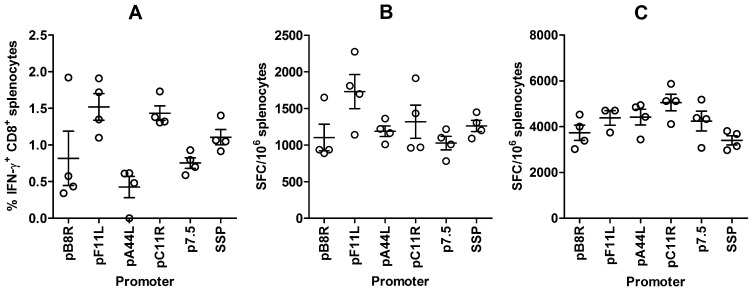
Cellular immunogenicity of recombinant MVA antigen (tPA-Pb9-rLuc8PV) driven by endogenous promoters compared to p7.5 and SSP in single-shot (A, B) or heterologous prime-boost (C) vaccination regimens.For single-shot (A, B), BALB/c mice were immunized i.m. with 106 pfu rMVA) and splenic CD8+ T cell responses to Pb9 peptide were determined 7 days later by intracellular cytokine staining and flow cytometry (A) or IFN-γ ELIspot (B). For prime-boost (C), BALB/c mice were immunized i.m. with 108 infectious units of AdCh63-tPA-Pb9-rLuc8PV and 56 days later received 106 pfu rMVA. At day 70 (14 days post-boost), splenic CD8+ T cell responses to Pb9 peptide were determined by IFN-γ ELIspot. Circles represent the responses of individual mice, with lines indicating the mean and the error bars showing SEM. See text for statistical analysis. The data shown are representative of two independent experiments.